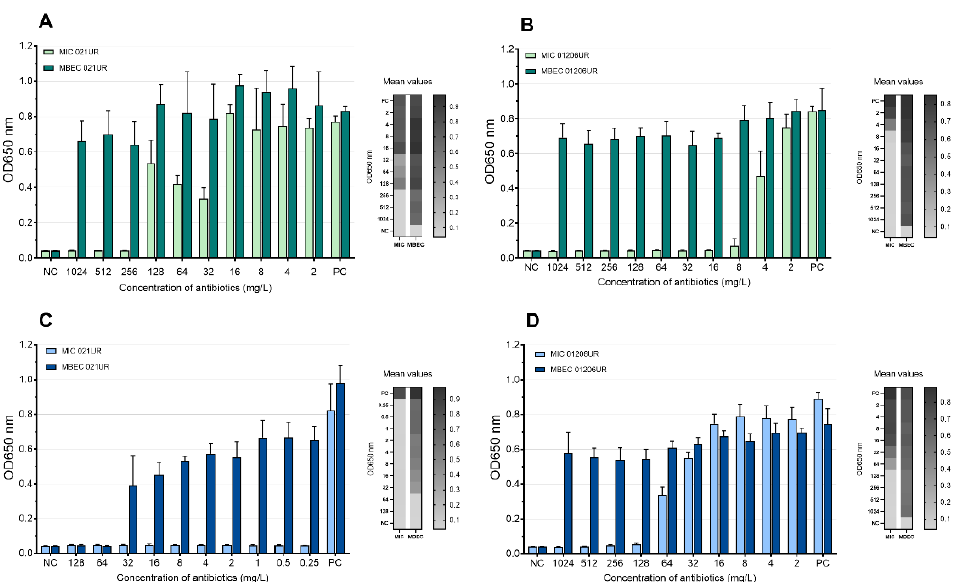
Figure 4. Mean MIC and MBEC antibiotic values. ( A ) Amoxicillin–clavulanic acid for 021UR; ( B ) amoxicillin–clavulanic acid for 01206UR; ( C ) ciprofloxacin for 021UR; ( D ) ciprofloxacin for 01206UR; NC—negative control; PC—positive control.